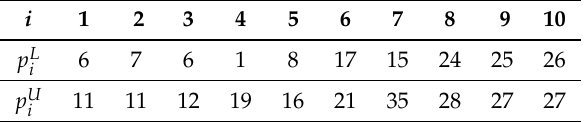
∈ J = { J } i 1 , J 2 ,. . ., J 10